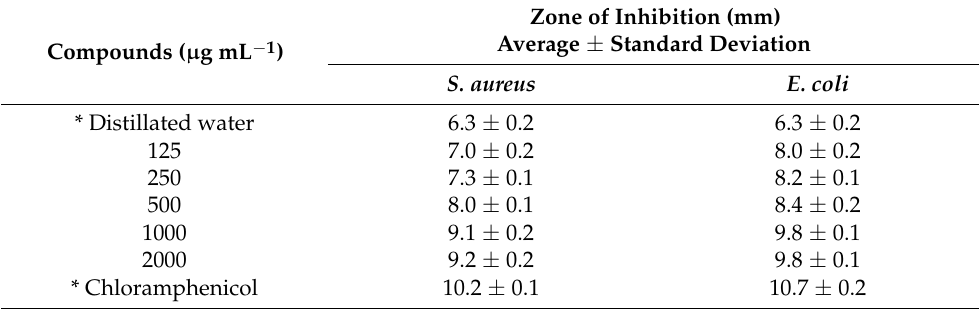
Table 1. Zone of inhibition (mm) of blank disks, ZnO against tested bacteria.